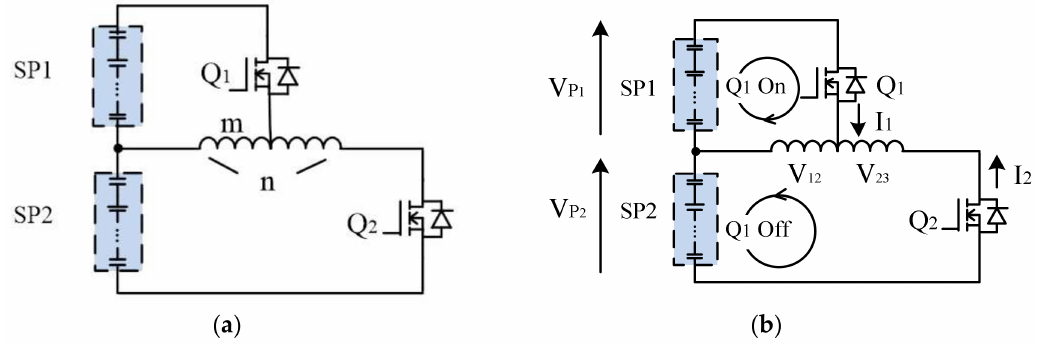
Figure 3. Tapped inductor balancing circuit. ( a ) Basic circuit; ( b ) Current flow during on and off states of